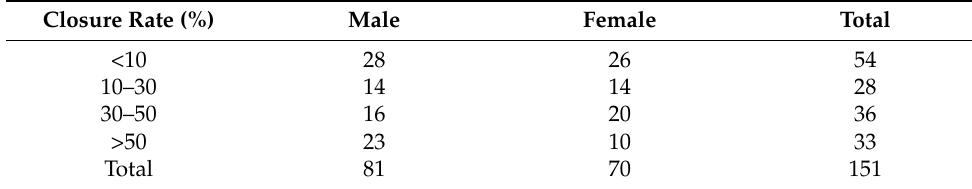
Table 1. Characteristics of subjects in coronary artery occlusion status.